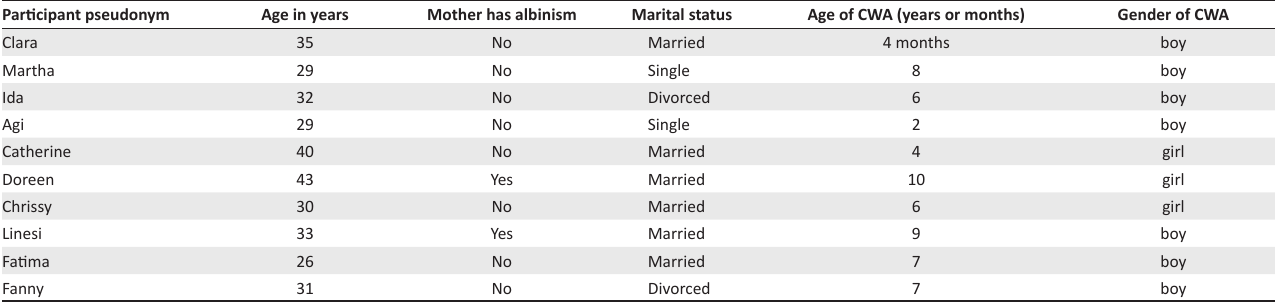
TABLE 1 : Demographic characteristics of study participants ( n = 10 Malawian mothers of a biological child with albinism). Participant